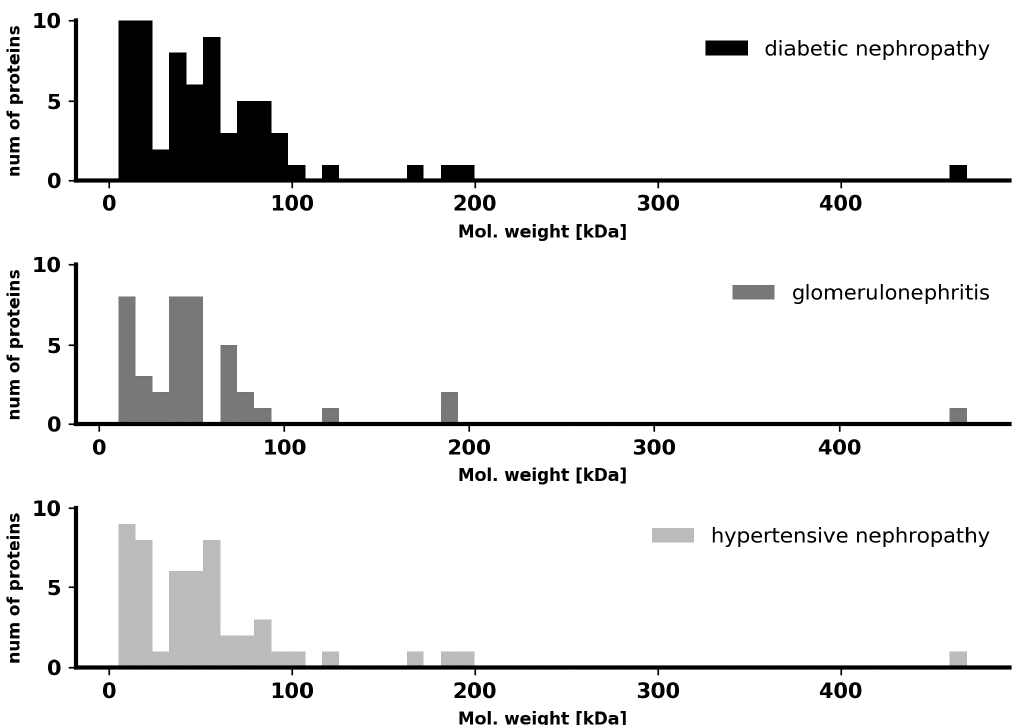
Figure 1. Distribution of urine proteins by molecular weight in the three studied groups of patients.